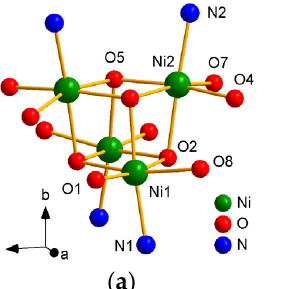
Figure 3. Cubane core ( a ) and fragment of structure 1 ( b ), emphasizing the binding mode of ligand (L 1 ) 2 − for Ni II .